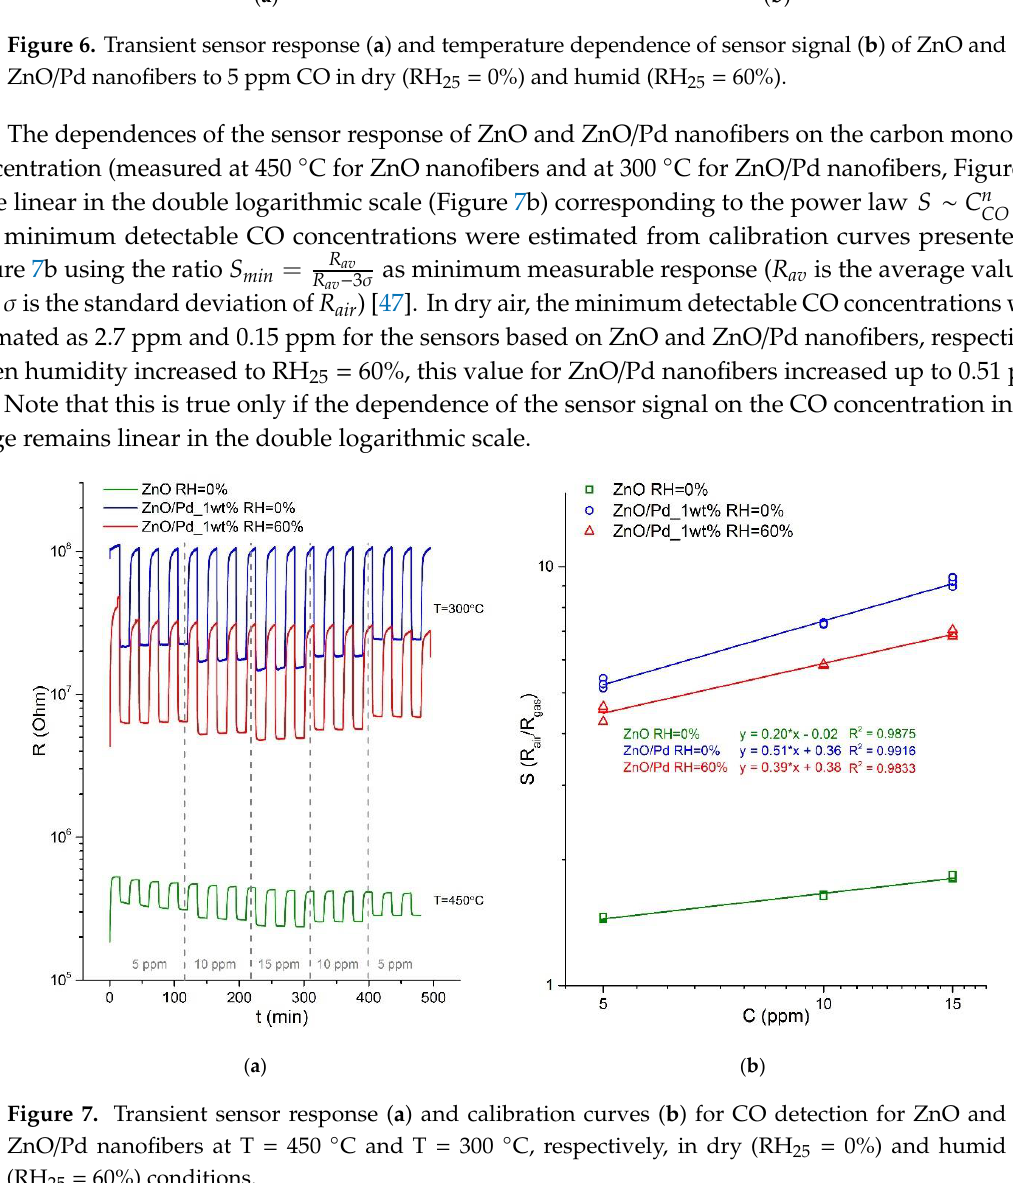
Figure 8. Diffuse reflectance IR Fourier transform spectroscopy (DRIFTS) of ZnO and ZnO/Pd nanofibers in humid air ( a ), in the presence of 500 ppm CO in dry air (RH 25 = 0%) ( b ), in the presence of 500 ppm CO in humid air (RH 25 = 60%) ( c ).